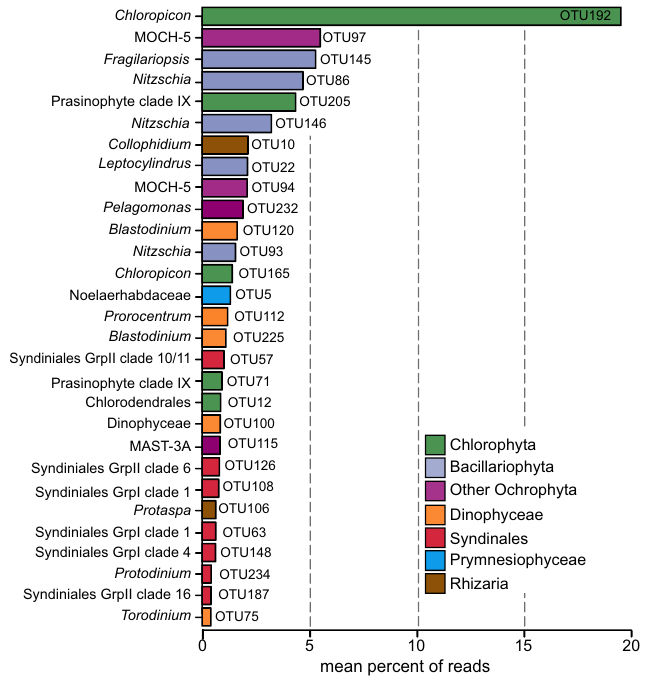
Figure 3. Barplot representing the average proportion of each of the 29 major OTUs distributed across all samples and all populations. Note that the major OTUs constitute at least 20% of the total reads per sample for at least one sample.